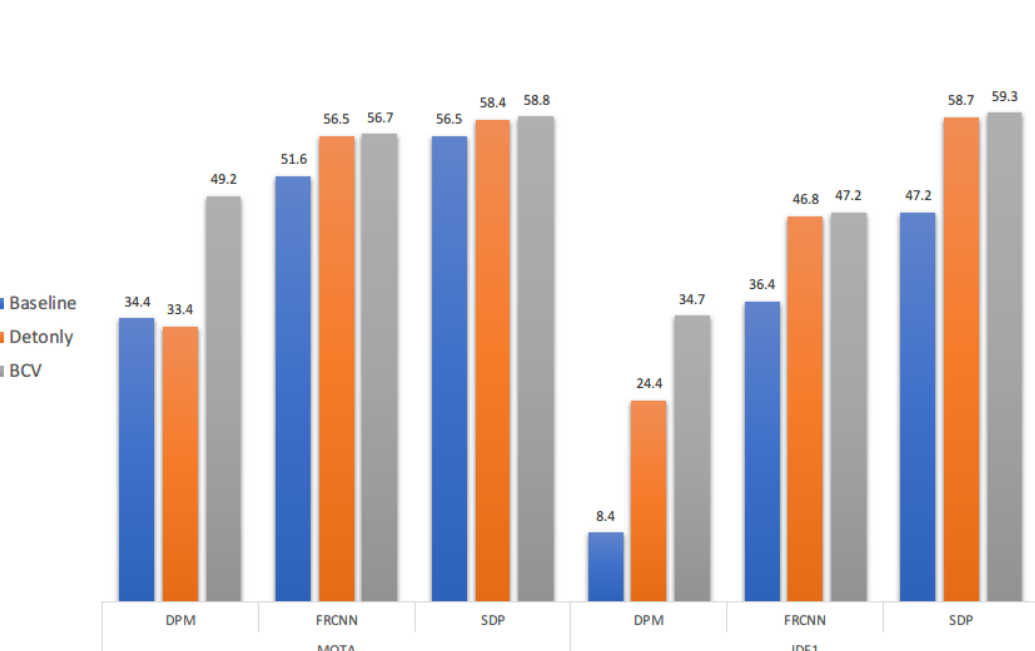
Figure 7. MOTA and IDF1 scores of our binary-channel verification model. We separate detection from a different external detector such as DPM, FRCNN, and SDP. Blue columns represent our baseline which is directly using the single object tracker under the MOT scenario, while orange ones are the results using detection only and discard all estimation from the single object tracker except for the ones occluded or undetected and grey ones are our binary-channel verification model